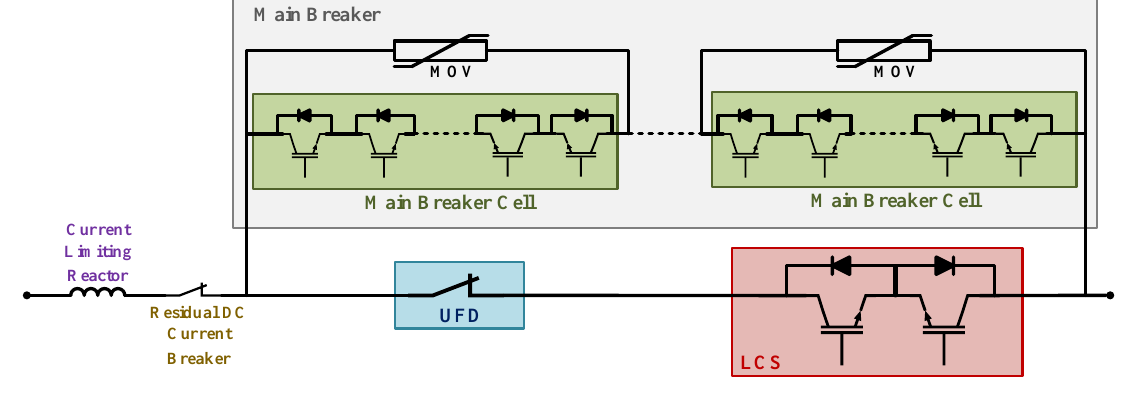
Figure 10. A hybrid DCCB